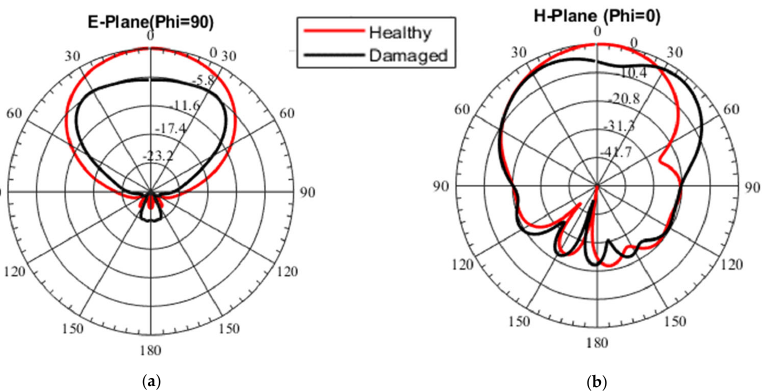
Figure 3. Simulated gain radiation patterns of healthy and damaged patch antenna in the ( a ) E-plane and ( b ) H-plane.